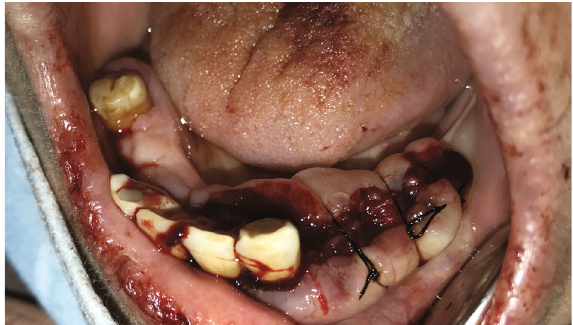
Figure 7: External bevel gingivectomy of the upper right quadrant.